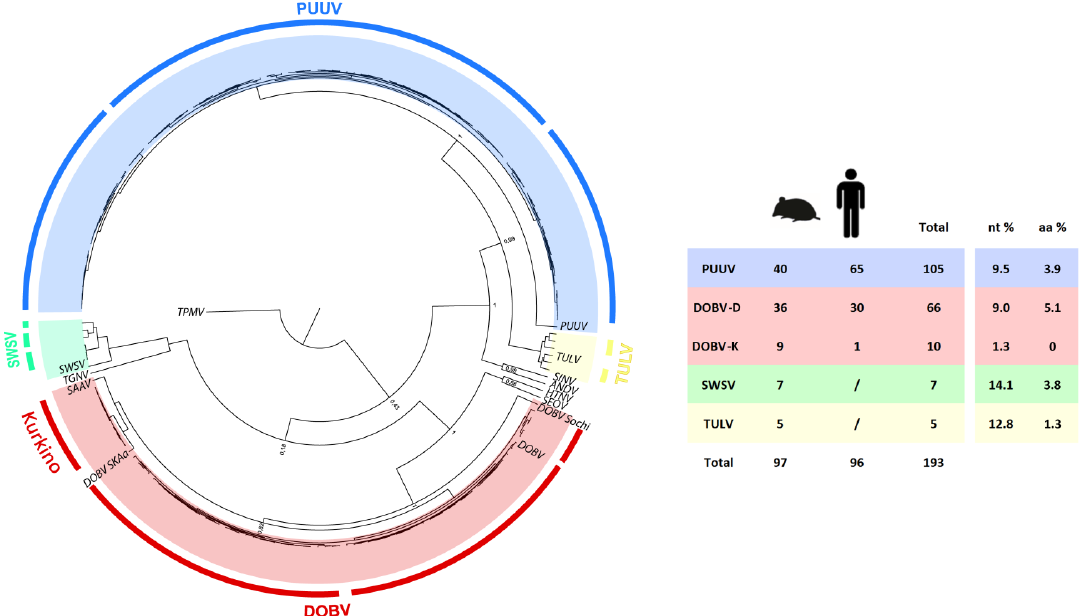
Figure 2. Tree representing bayesian phylogenetic analysis of L segment (235 bp) of Slovenian hantavirus genotypes, under the best-fit HYK + G model of evolution, four MCMC runs of 10,000,000 generations. The table shows the number of obtained sequences from small mammals and patients, as well as pairwise nucleotide (nt) and deduced amino acid (aa)